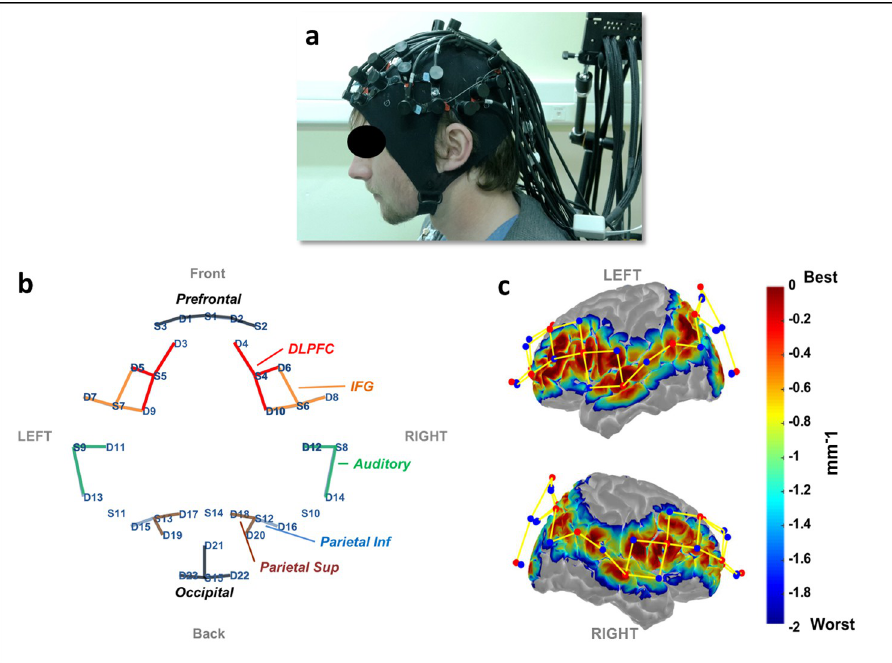
Fig 1. Graphic representation of fNIRS data collection. a) Photography of the optode-array holder placed on the head of one of the participants for demonstration purposes. (b) 2D representation of ROI location; each line represents a measurement channel between source (S) and detector (D) optodes. (c) Left (up) and right (down) views of the cortical sensitivity maps obtained using Monte-Carlo simulation within Atlas Viewer (V2.8; default parameters except for the number of photons that has been set to 10 7